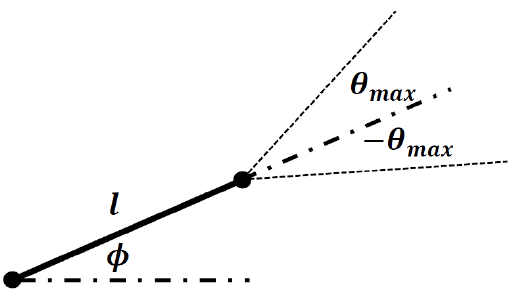
Figure 2. Angle of deviation of the second segment with respect to the previous one.